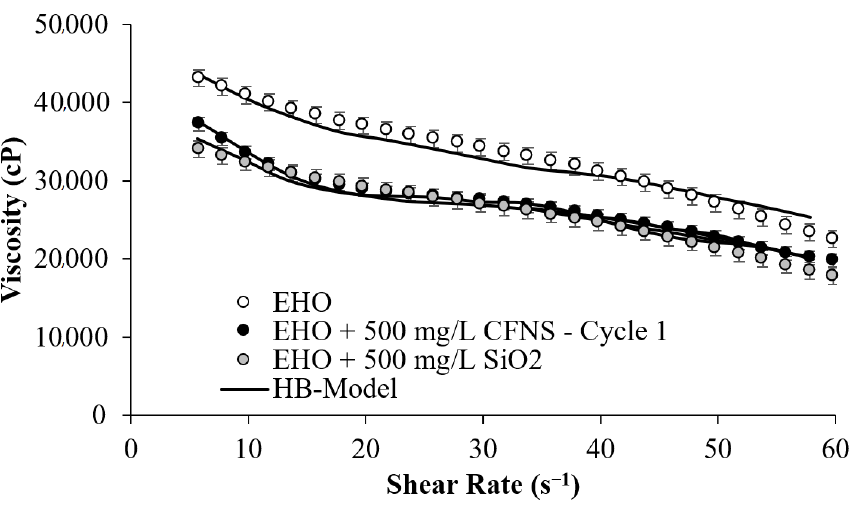
Figure 6. Flow curve for EHO in the presence of CFNS and SiO 2 nanoparticles, and the Herschel– Bulkley model correlation at 25 °C and 500 mg/L.